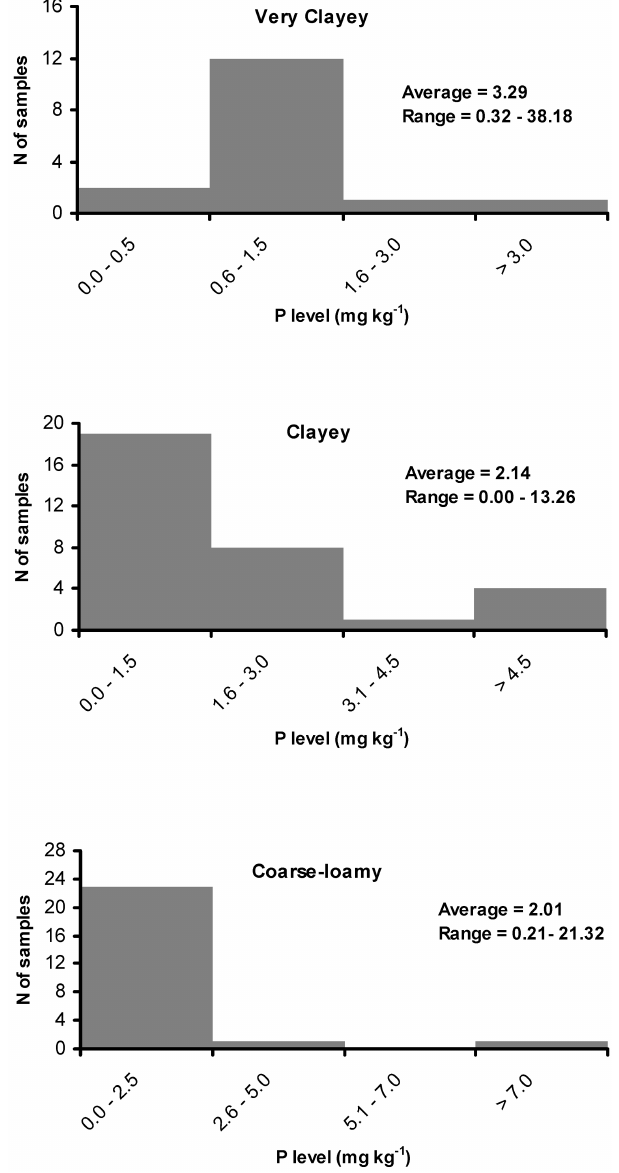
Fig. 3 – Classes and frequency distribution for phosphorus levels according to Sousa et al. (2001), for forage